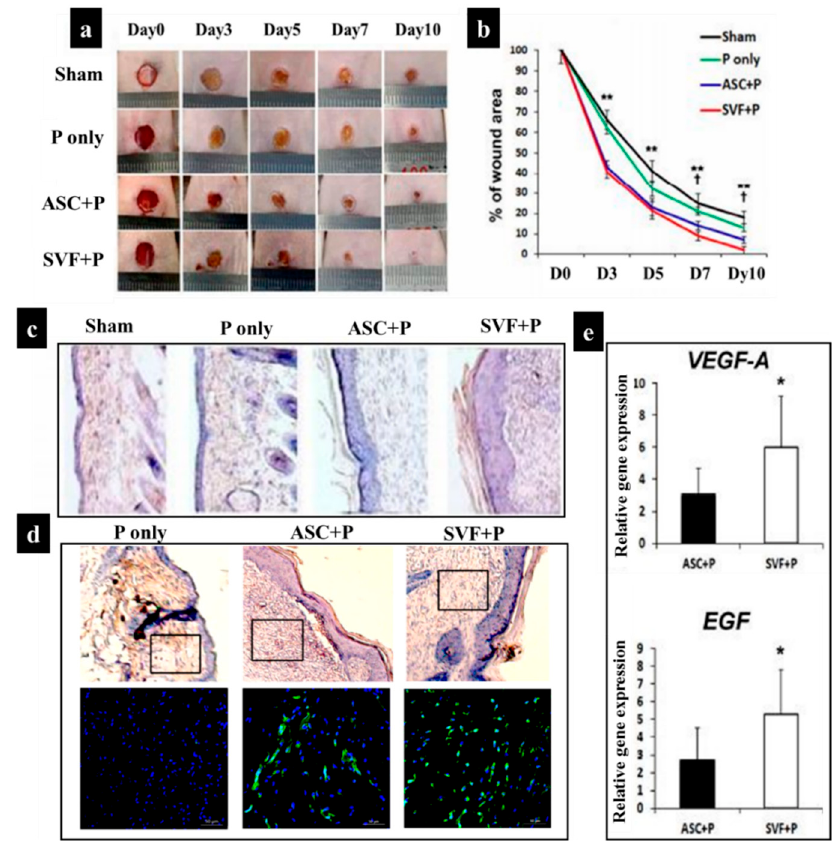
Figure 6. ( a ) Wound contraction over a 10-day period in four groups: sham, pluronic hydrogel (P) only, ASC+P, and SVF+P; ( b ) diagram showing the percentage of wound area each day; ( c ) histological images after H&E staining at 14 days after the injection of cells. ( d ) Representative photographs of isolectin B4 (ILB4), which is a marker of endothelial cells for neovascularization, in the skin wounds at 14 days after cell transplantation; nuclear DAPI staining is blue and ILB4 staining is green. On the upper line of the picture are the results of H&E from wound tissue after cell injection. The black rectangular box indicates the location of endothelial cells that show capillary density. ( e ) Quantification of expression levels for VEGF-A and EGF in skin wound tissues (* p < 0.05, ** p < 0.01)